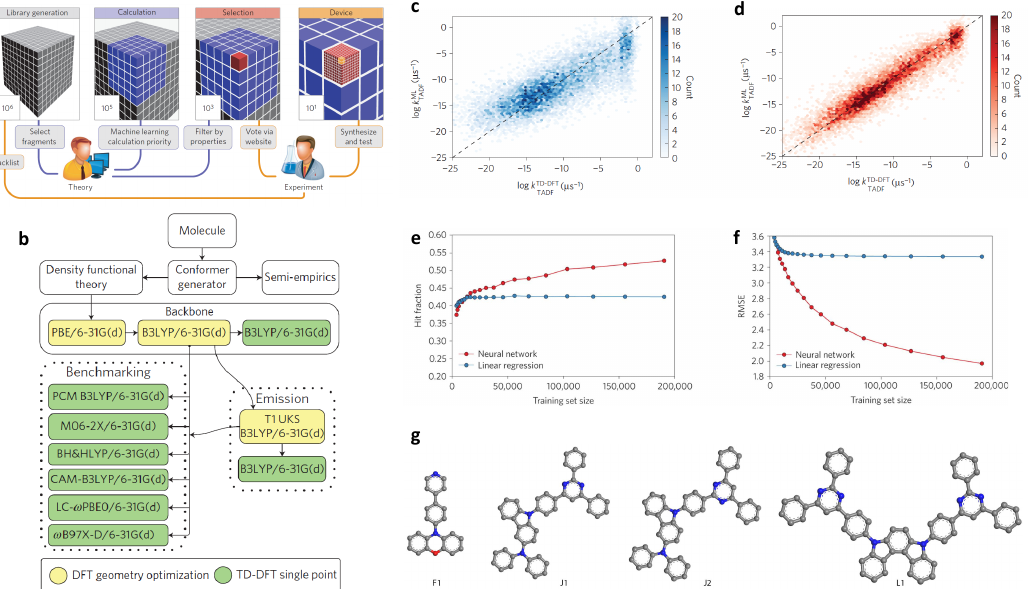
Figure 3. Integrated design of organic light-emitting diodes (OLEDs). ( a ) Schematic of the integrated design method; ( b ) flow chart of quantum chemical computation; ( c , d ) the coefficient of determinant for linear regression (0.80) and neural network (0.94); ( e , f ) the relation between hit fraction and root mean square error (RMSE) with respect to the training set size; ( a – f ) are adapted from Reference [83] with permission, copyright 2016 Springer Nature; ( g ) the best candidate molecular structures (gray, blue, and red nodes) denote carbon, nitrogen, and oxygen atoms,